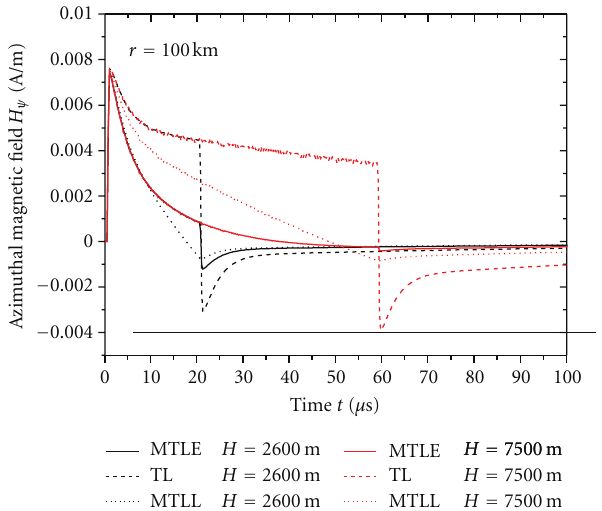
Figure 14: Azimuthal magnetic field at 5km from the channel-base for MSS FST, three di ff erent models and two channel heights ( H = 2600 m and 7500 m).